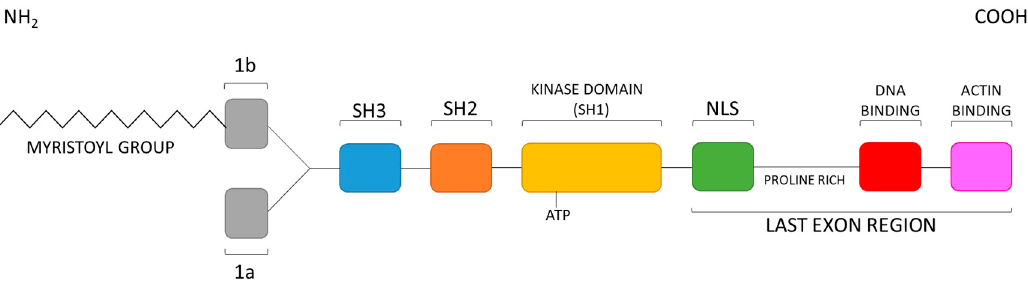
Figure 1. Abl domain order.